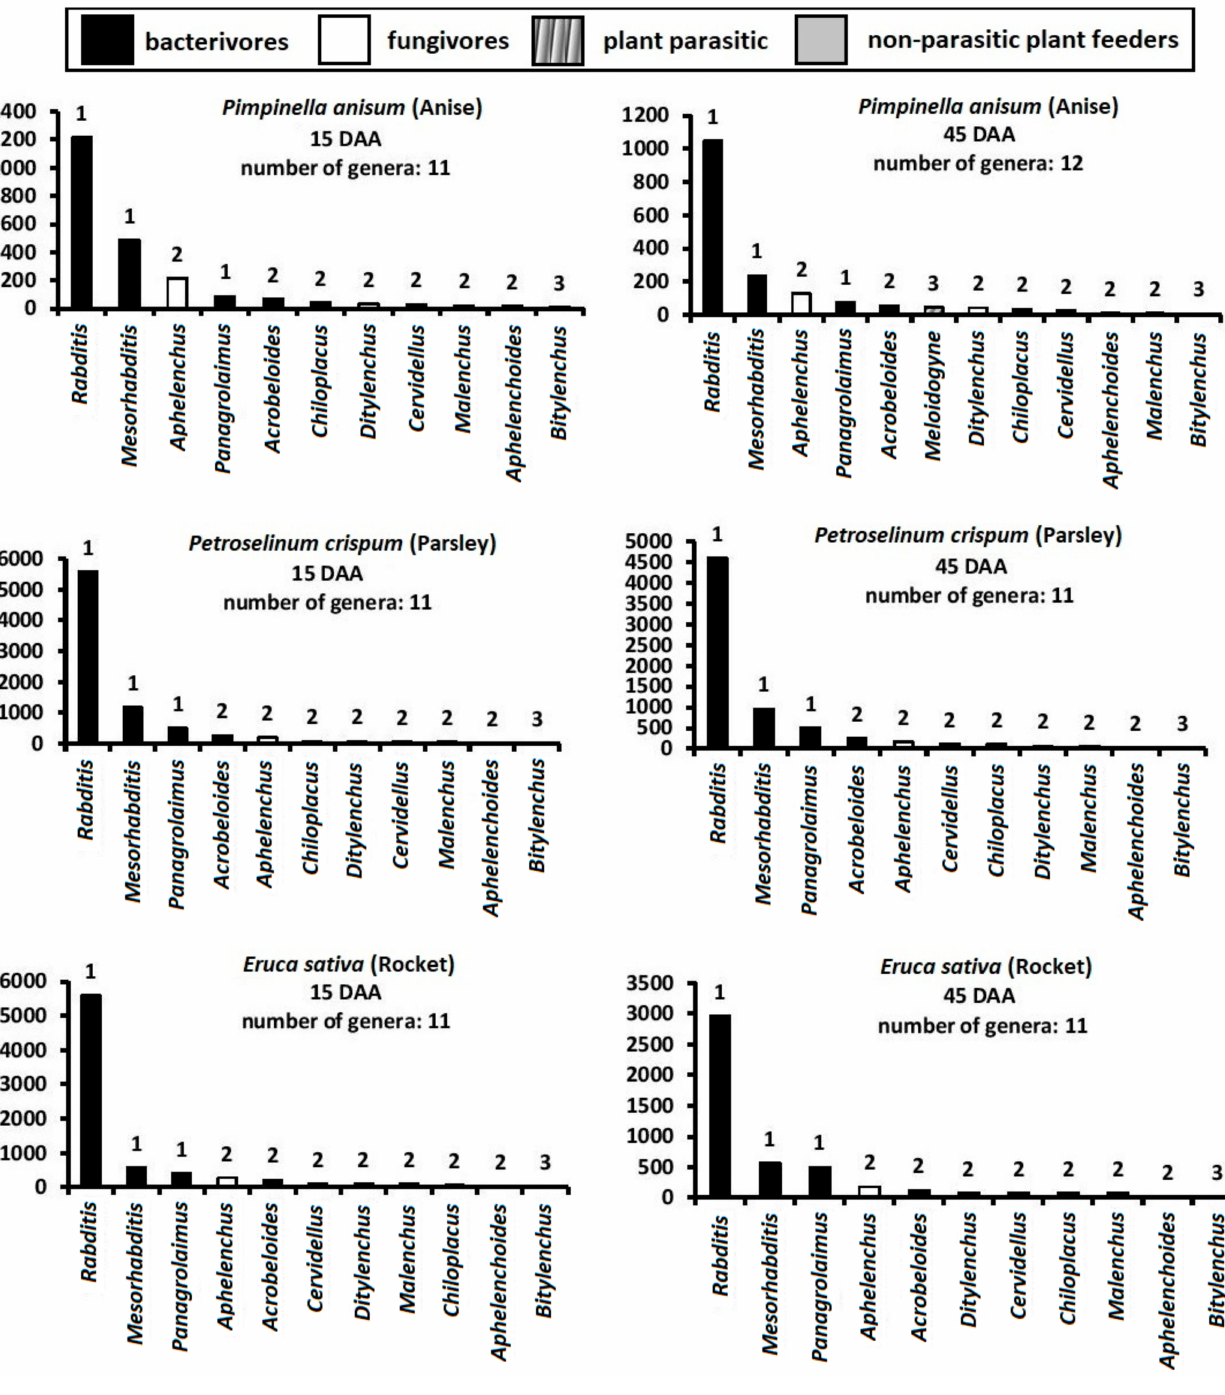
Figure 2. Rank abundance graphs for nematode genera at different treatments 15 and 45 days after application (15 DAA, 45 DAA). Genera are ranked from the most to the least abundant. Numbers above bars indicate the c–p value of each genus. For all cases n =